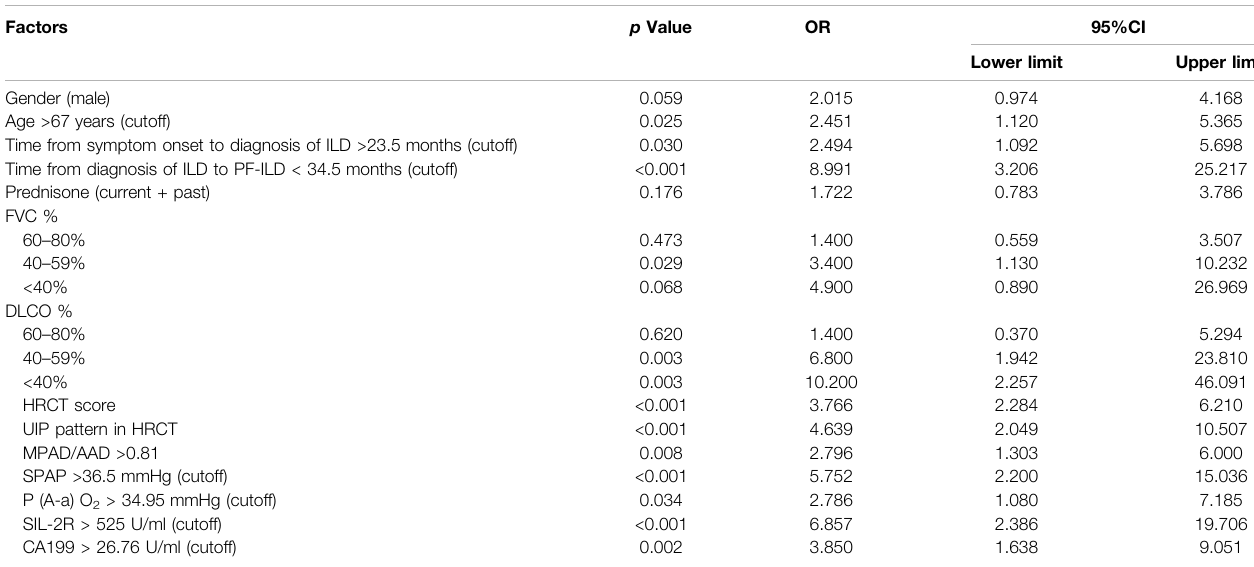
TABLE 4 | Factors associated with mortality in patients of